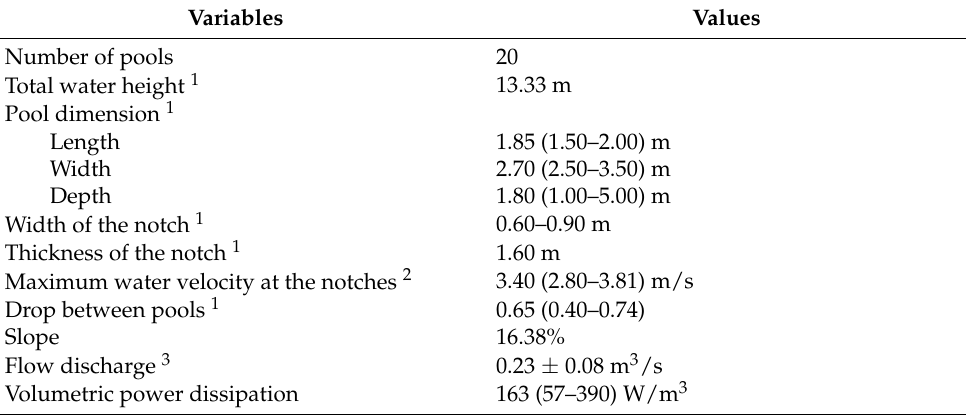
Table 1. Mean geometric and hydraulic variables for the studied fishway. Range of values in brackets.